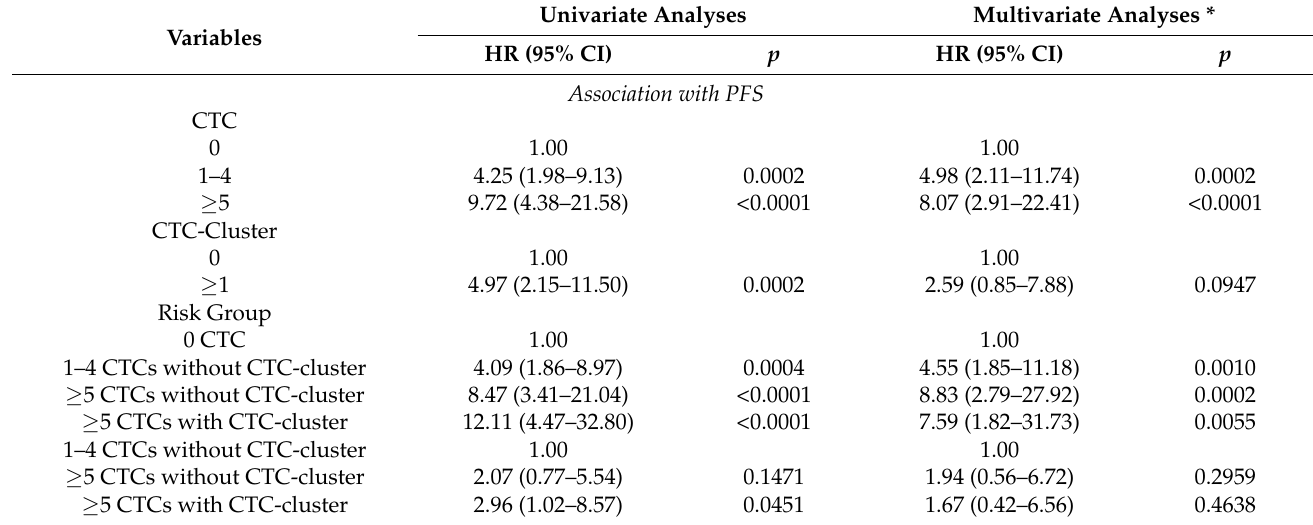
Table 3. Associations Time-dependent analysis of CTCs and CTC-clusters with clinical outcomes.